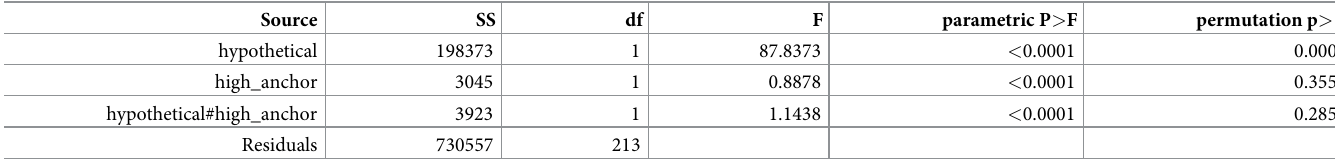
Table 5. Experiment 1: Permutation